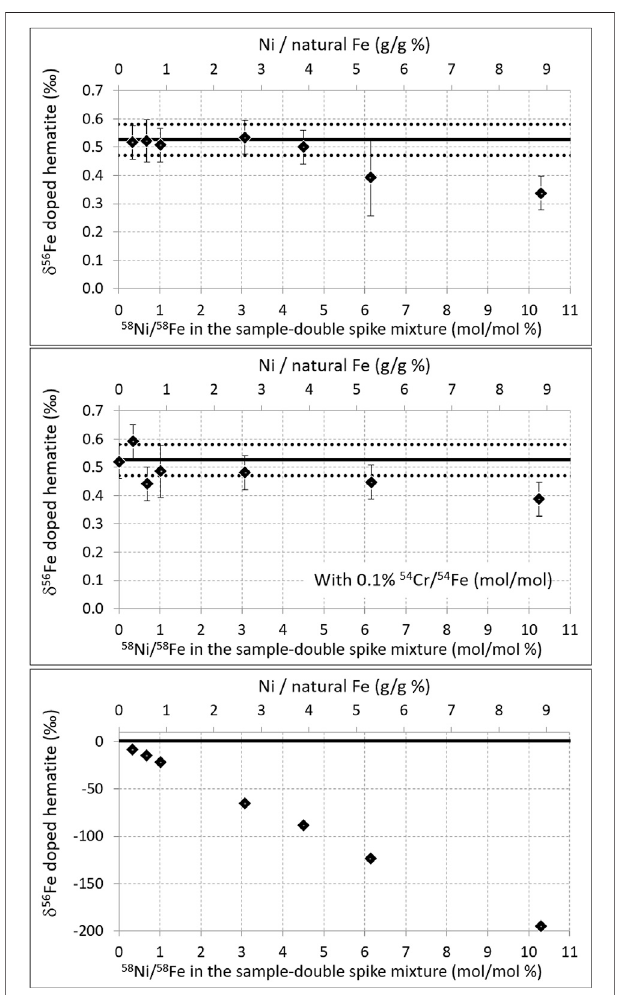
FIGURE 3 | Top: same as Figure 2 , but for variable amounts of Ni. Middle:same astop but withan addition ofCr leadingto0.1% 54 Ni/ 54 Fe (mol/ mol) in all samples. Bottom: same as top but with no Ni interference correction (note the different vertical scale).